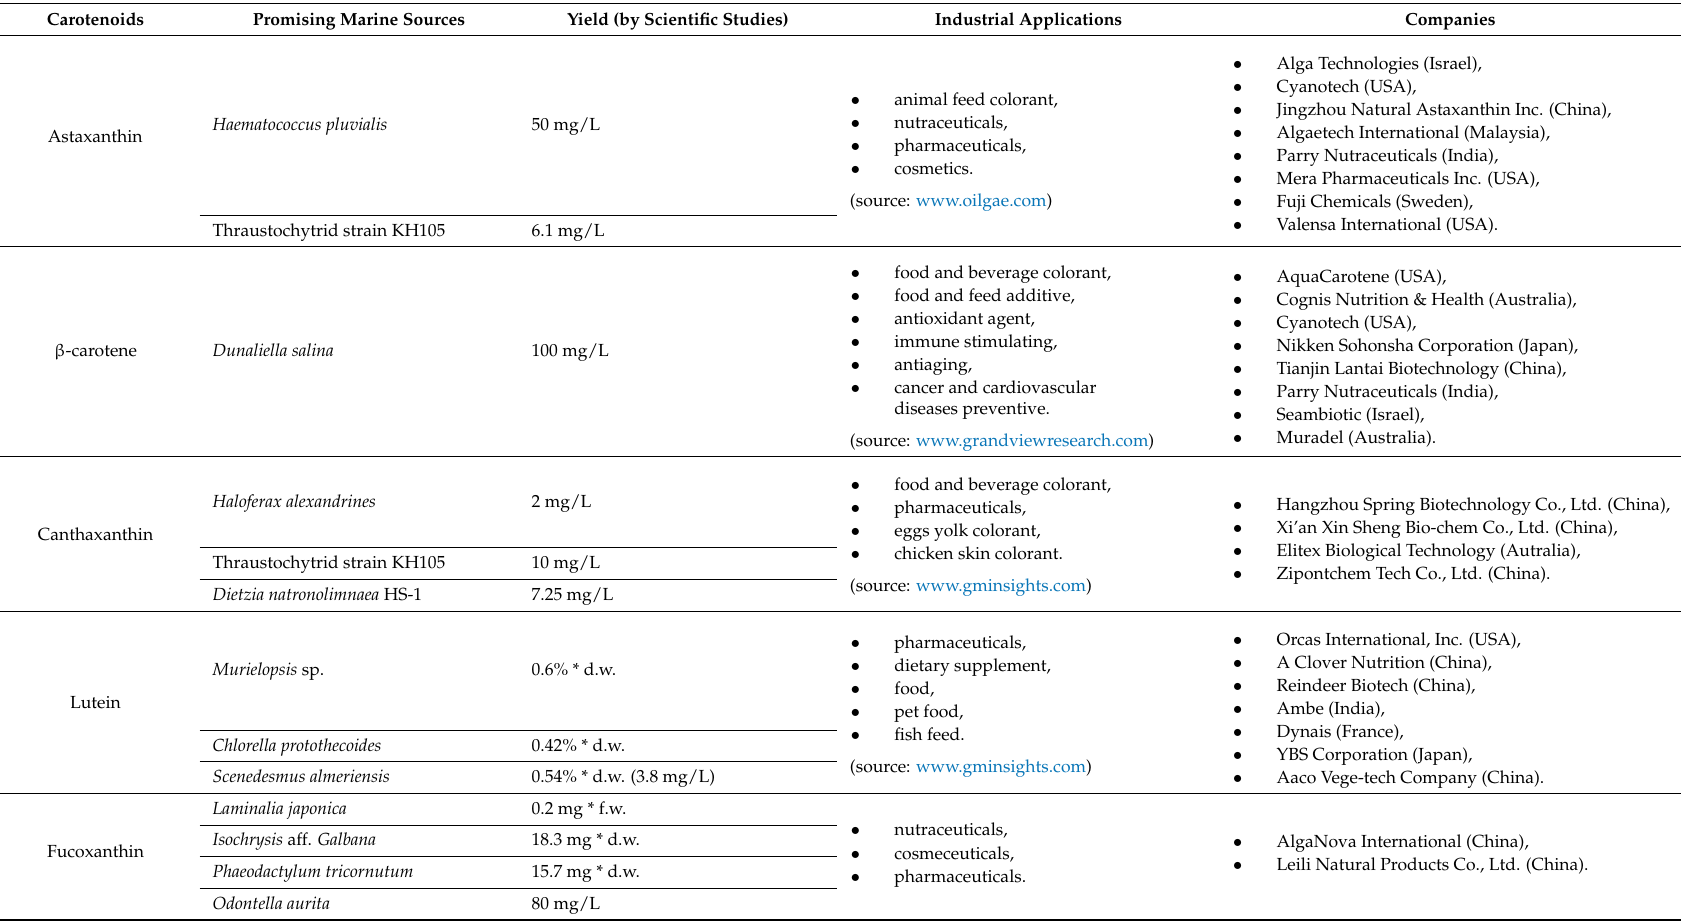
Table 3. Main industrially produced carotenoids, their new potential marine sources and world manufacturing